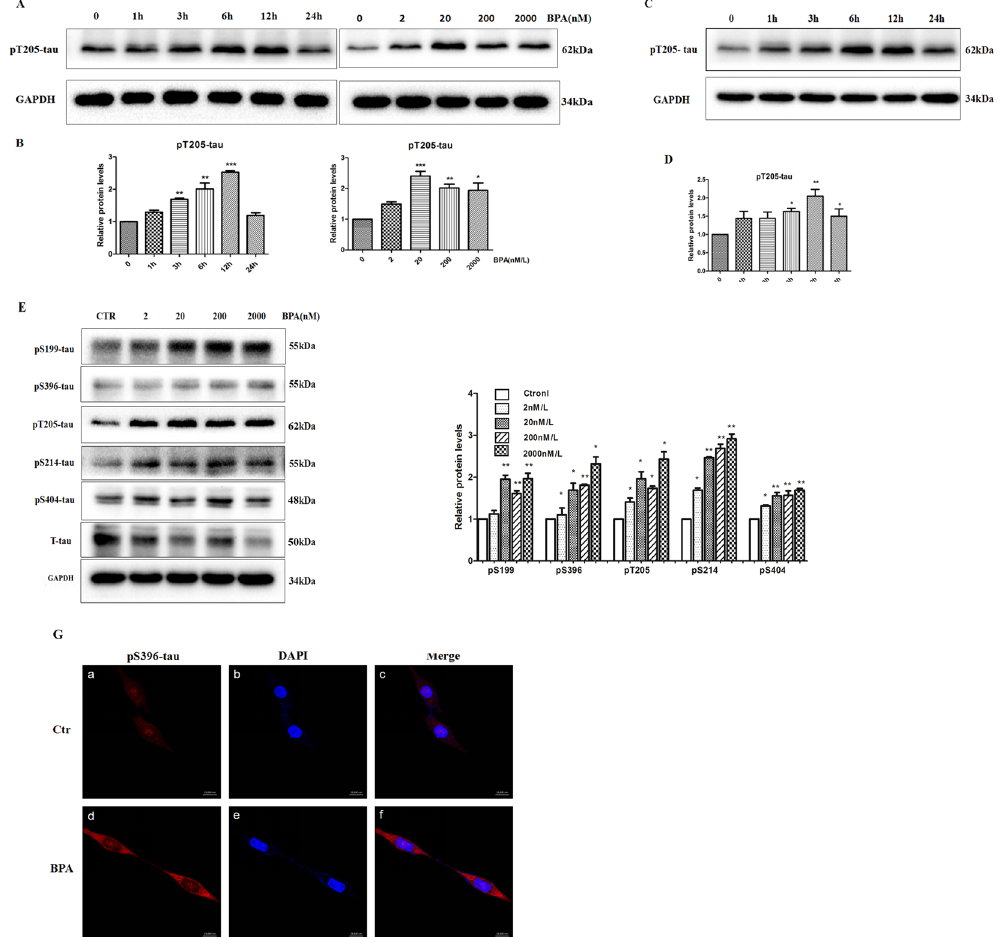
Figure 3. BPA enhanced the expression of phosphorylated tau. Western blot analysis indicated the expression of phosphorylated tau in SY5Y cells treated with 20 nM/L BPA ( A ) at different concentrations (0, 2, 20, 200, and 2000 nM/L) and various time points (0, 1, 3, 6, 12, and 24 h). ( C ) Expression of phosphorylated tau in PC-12 cells treated with 20 nM/L BPA at various time points (0, 1, 3, 6, 12, and 24 h) of BPA. ( E ) Expression of phosphorylated tau in PC-12 cells treated with different concentrations of BPA (0, 2, 20, 200, and 2000 nM/L). ( D , F ) GAPDH levels were detected in parallel and served as controls. ( G ) Immunofluorescence analysis of the expression of p-tau after treatment with 20 nM/L BPA. Mean values ± SEMs are representative of three independent isolations and three independent samples. Significant differences between the treatment groups and the control group were determined via one-way ANOVA and the Dunnett multiple comparison procedure. ( * P < 0.05, ** P < 0.01, *** P < 0.001 compared with the control